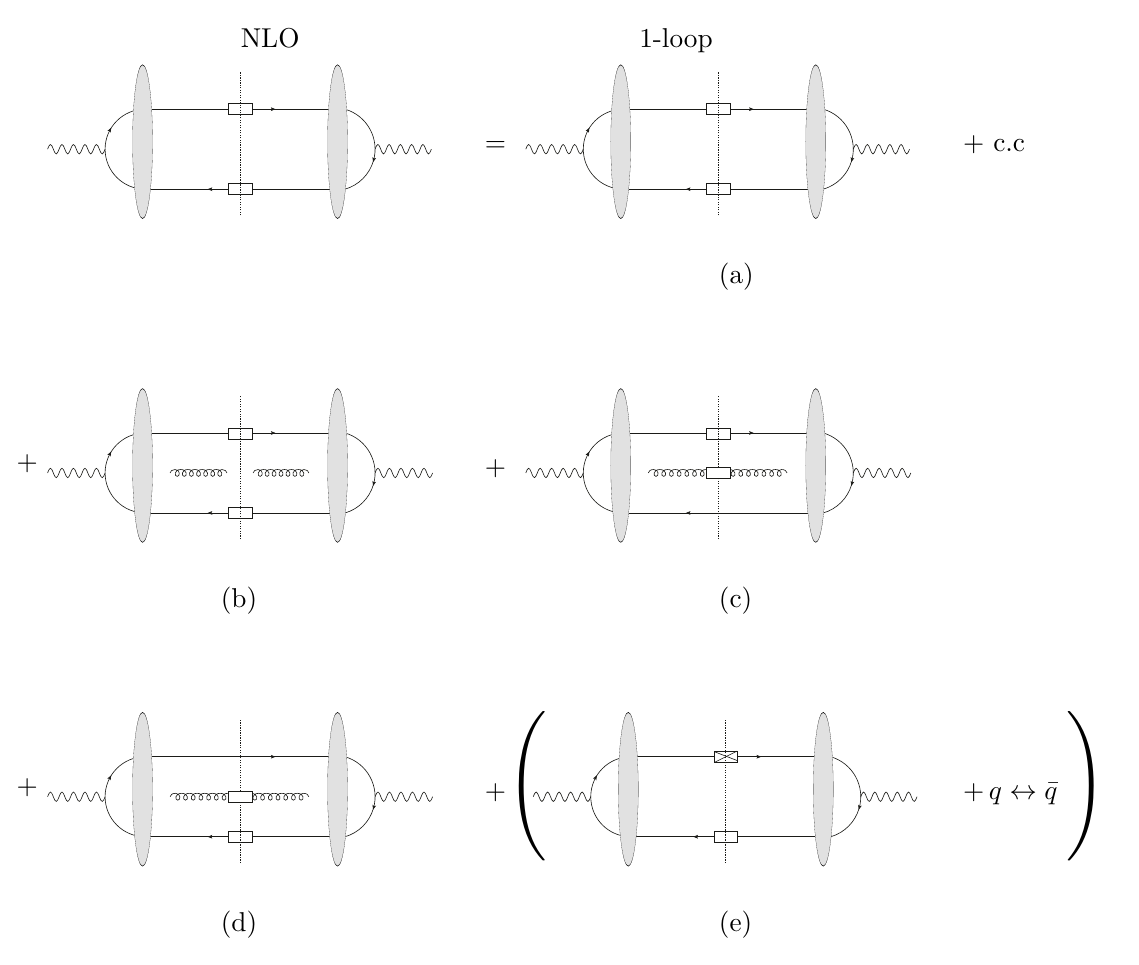
Figure 5 . The 5 kinds of contributions to the NLO